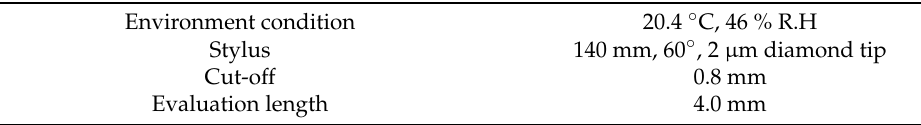
Table 3. Surface roughness test